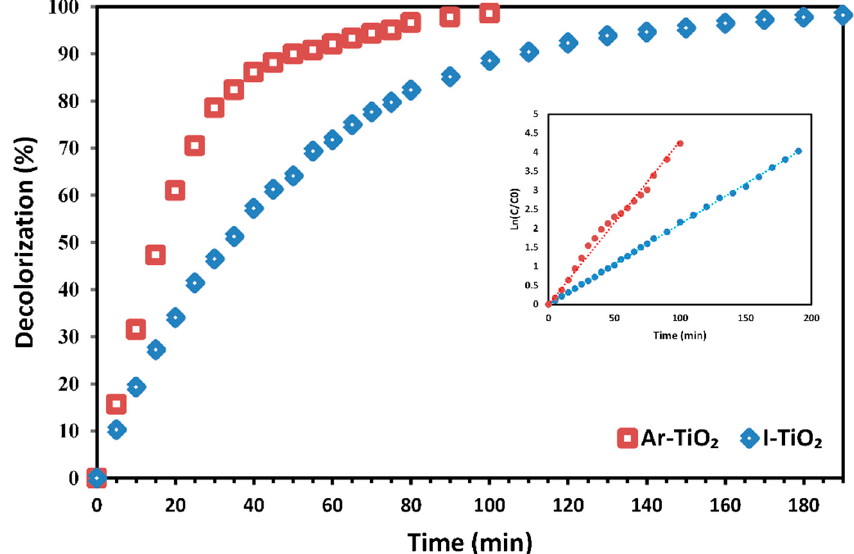
Figure 10. Crystal violet decolorization efficiency of plasma-treated and non-treated TiO 2 nanoparticles immobilized on glass plates; initial reaction conditions: [CV] = 10 mg/L and [H 2 O 2 ] = 13 mM.